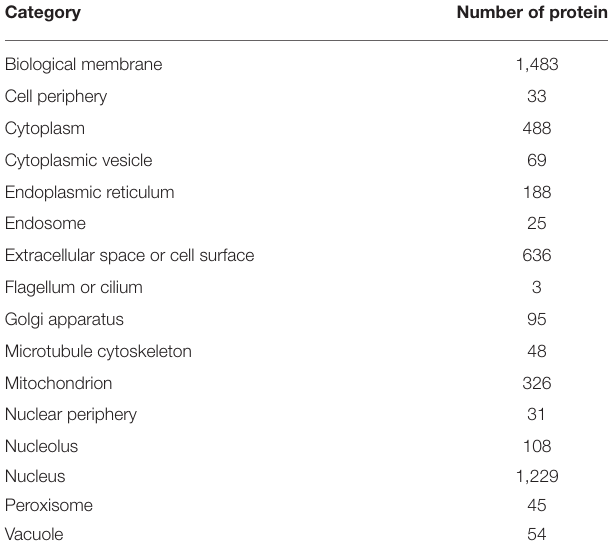
TABLE 1 | Number of proteins in each